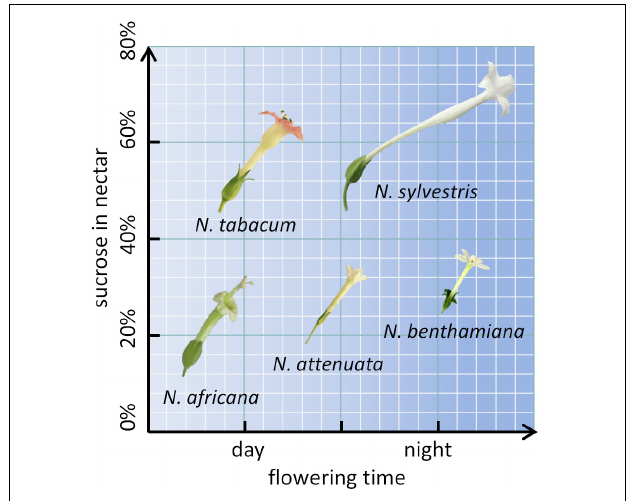
FIGURE 1 | Nicotiana species arranged by flowering time and sucrose content. The flower sizes are depicted to relative scale.